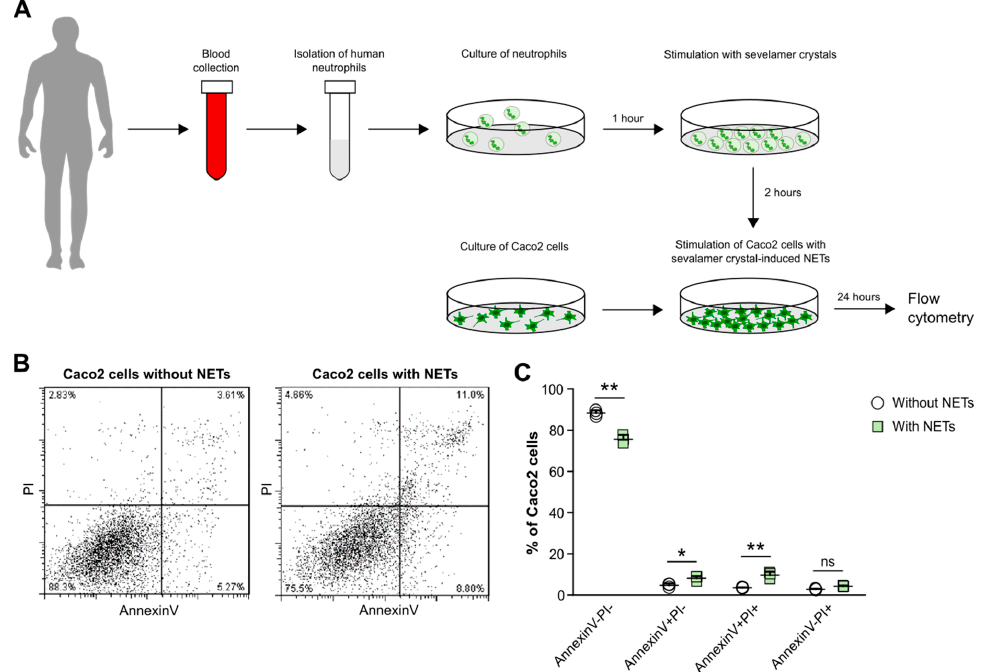
Figure 7. Soluble mediators released from ion-exchange resin crystal-induced neutrophil extracellular traps drive cell death in intestinal epithelial cells. ( A ) Schematic showing work flow. Human blood neutrophils were isolated from healthy individuals and stimulated with or without sevelamer crystals (1000 µ g / mL). After 2 h, supernatants with or without neutrophil extracellular traps (NETs) were collected and incubated with Caco2 cells for 24 h. ( B , C ) After stimulation, the percentage of live was quantified by flow cytometry ( n = 3). Data are means ± SD. * p ≤ 0.05; ** p ≤ 0.01; ns, not